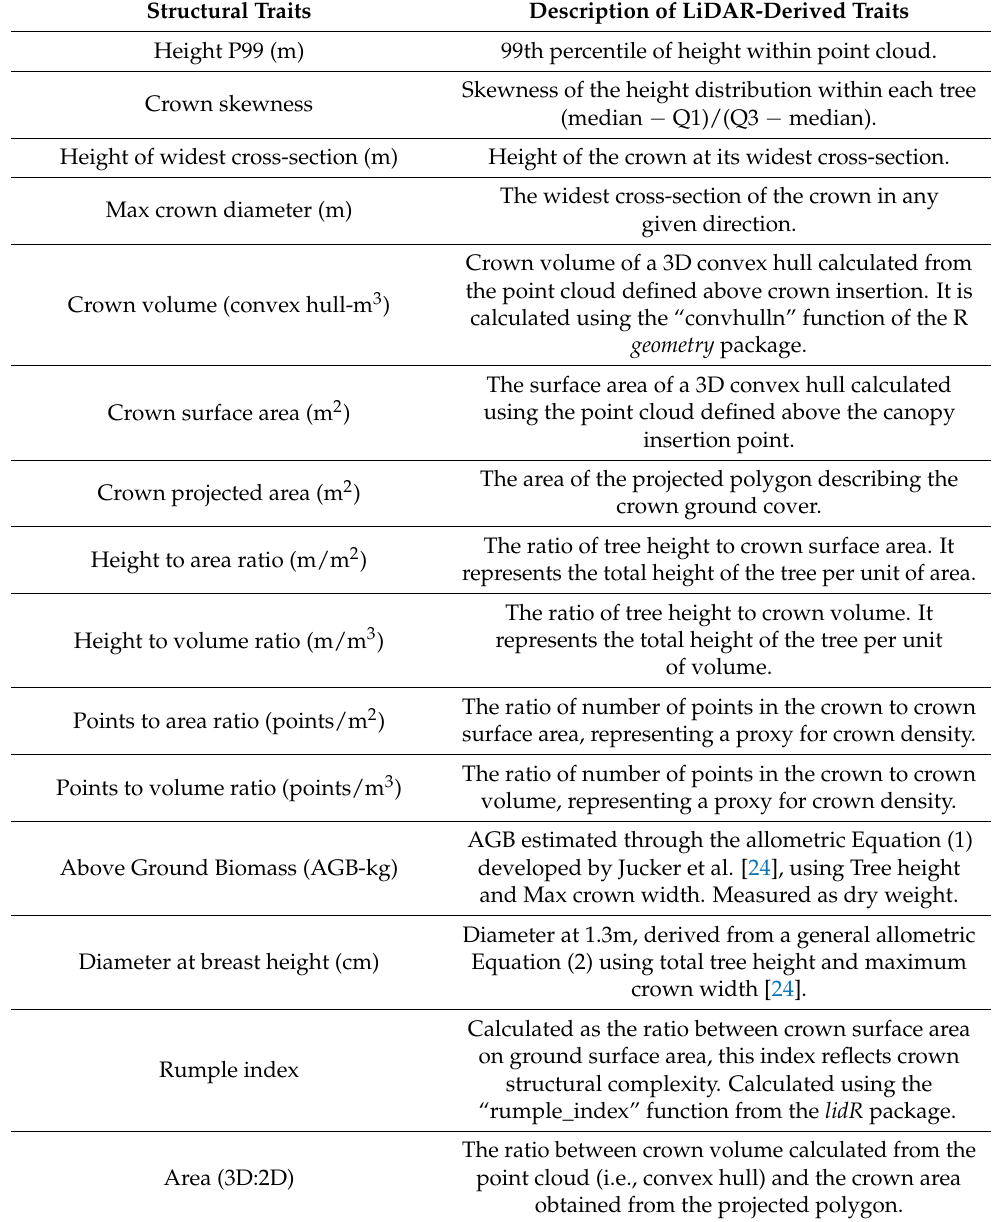
Table 2. List and description of the 15 structural traits computed for each individual tree extracted from the LiDAR point